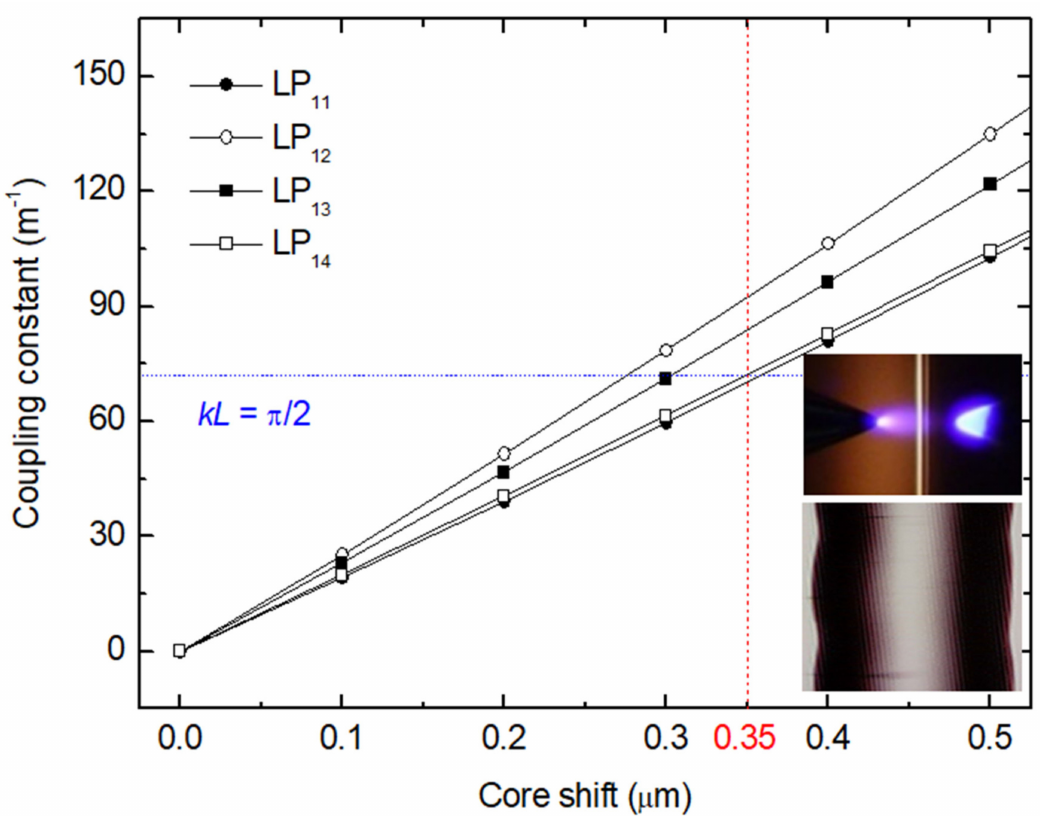
Figure 14. Coupling constant as a function of the core shift. Inset: Photograph of the microdeformation (fiber compressed on its length, showing two modulations separated by 540 µ m) caused by the temperature gradient of the DC arc discharge. Adapted with permission from ref. [103]. © 2007 The Optical Society.